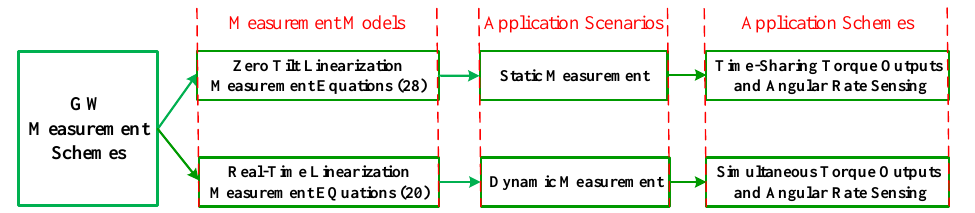
Figure 3. Measurement schemes of spacecraft angular rates with GW in different working